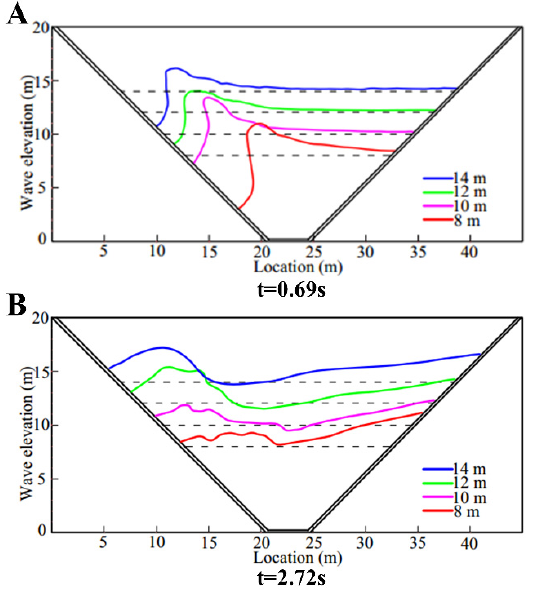
Figure 4. Fluctuation of free water level at the crossed section in different water depths: ( A ) t = 0.69 s; ( B ) t = 2.72 s.